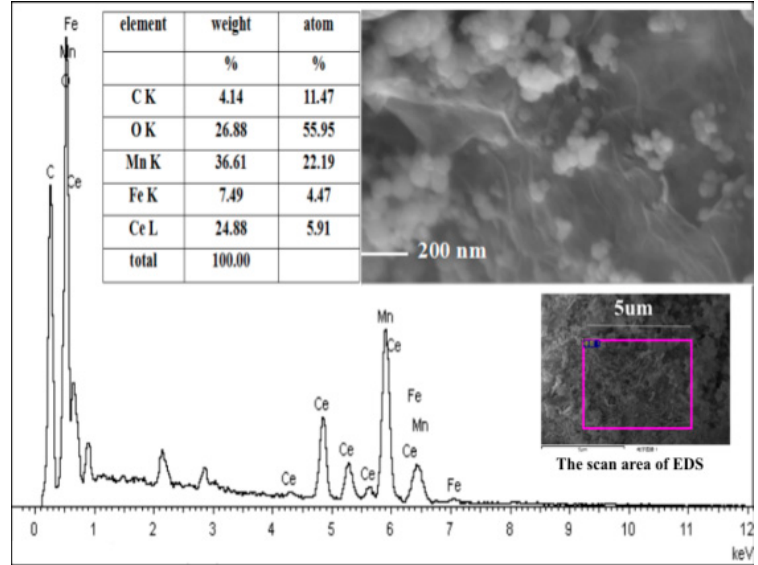
Figure 2. The element contents on the surface of graphene oxide (EDS) and scanning electron microscope (SEM) images of Ce-Mn-Fe/GO-20%.